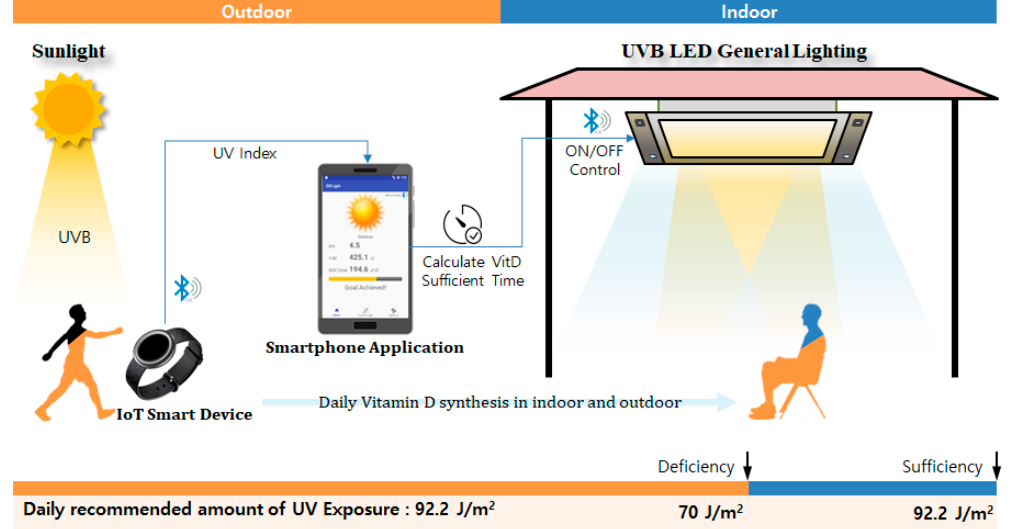
Figure 1. Conceptual drawing of the UVB general lighting system.